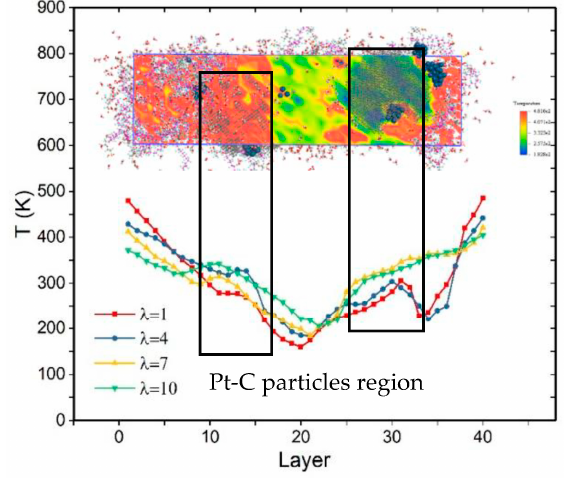
Figure 12. Temperature distribution of CL and its uneven gradient with different λ .